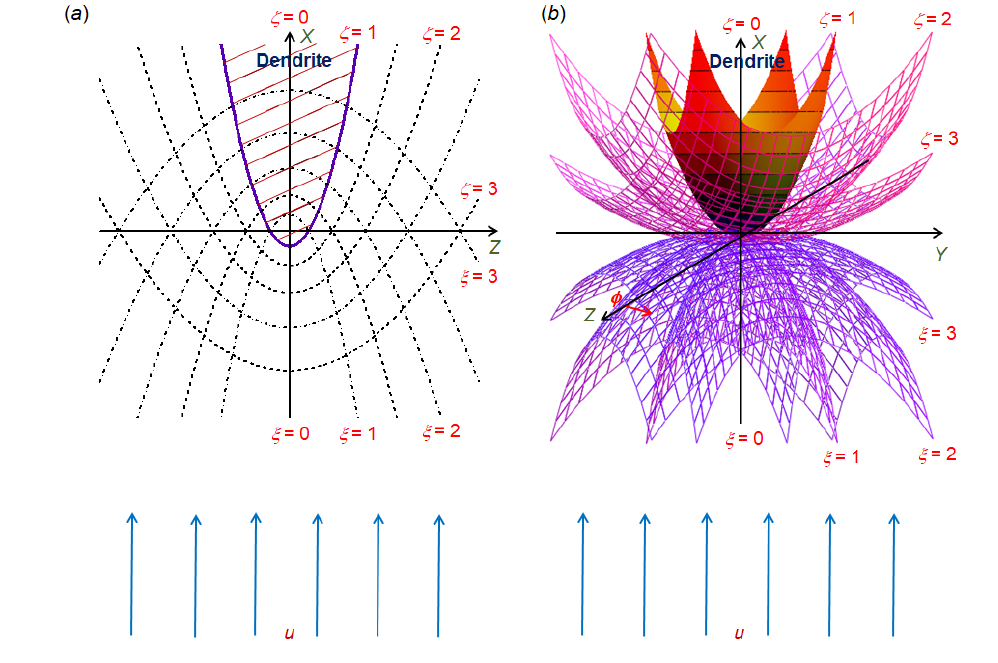
Figure 2. A scheme of a dendritic vertex swept by an undercooled melt (2D in ( a ) and 3D in ( b )). The figure shows the dendrite vertex and the isothermal (isoconcentration) surfaces ζ = const. around